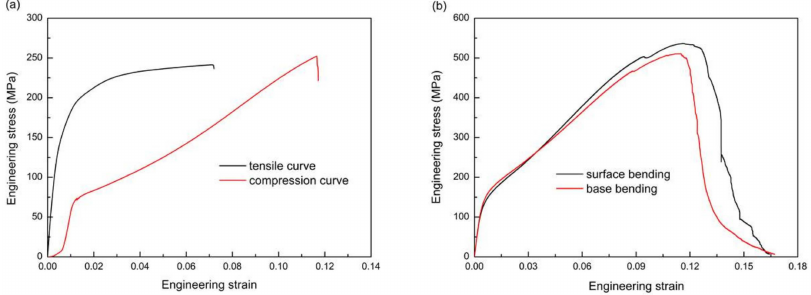
Figure 5. Engineering stress-strain curves of FSWed AZ31 Mg alloy joints during ( a ) tension and compression ( b ) surface bending and base